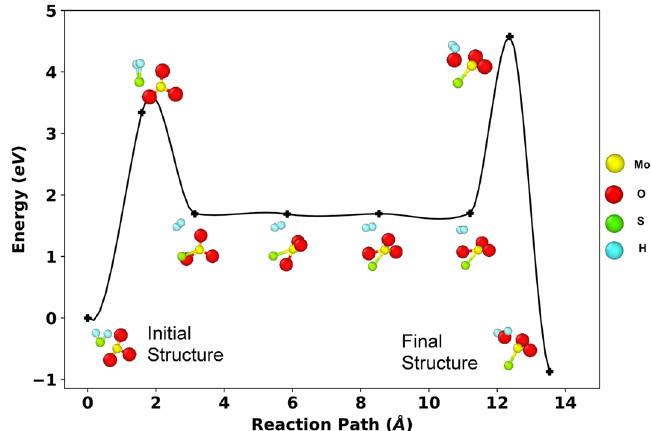
Figure 2. Reaction path and associated energy diagram obtained from Nudged Elastic band-Transition State (NEB-TS) calculations. Here, yellow, red, green, and blue colored spheres represent the molybdenum, oxygen, sulfur and hydrogen atoms, respectively. These colors are used to identify these atoms throughout the whole